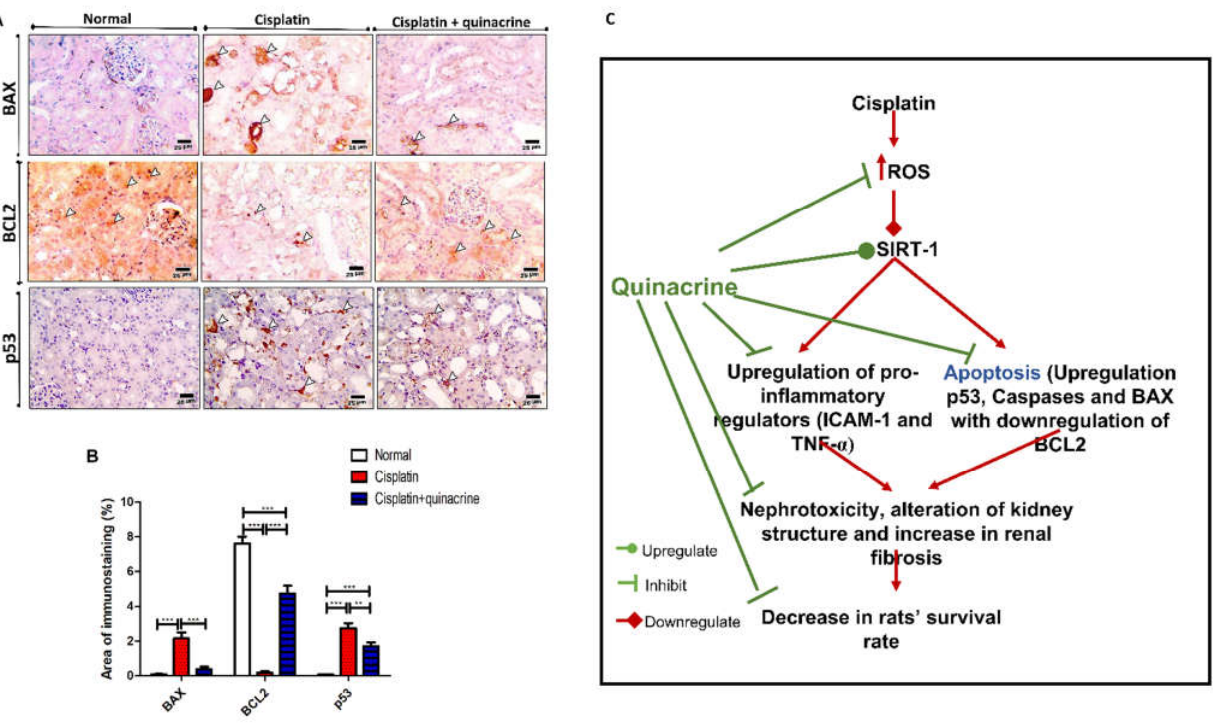
Figure 4. Quinacrine attenuated cisplatin-induced increase in apoptotic proteins and decrease in antiapoptotic protein. ( A ) Microscopic pictures of immunostained renal sections against BAX, BCL2 and p53; arrowheads point to positive brown reaction; high magnification X:400 bar 25. ( B ) Area of immunostaining of BAX, BCL2 and p53 (%) ( n = 6). **: p < 0.01, ***: p < 0.001. ( C ) Schematic diagram showing potential pathway of quinacrine’s renoprotective effect against cisplatin-induced toxicity. Data are expressed as mean ± SEM.